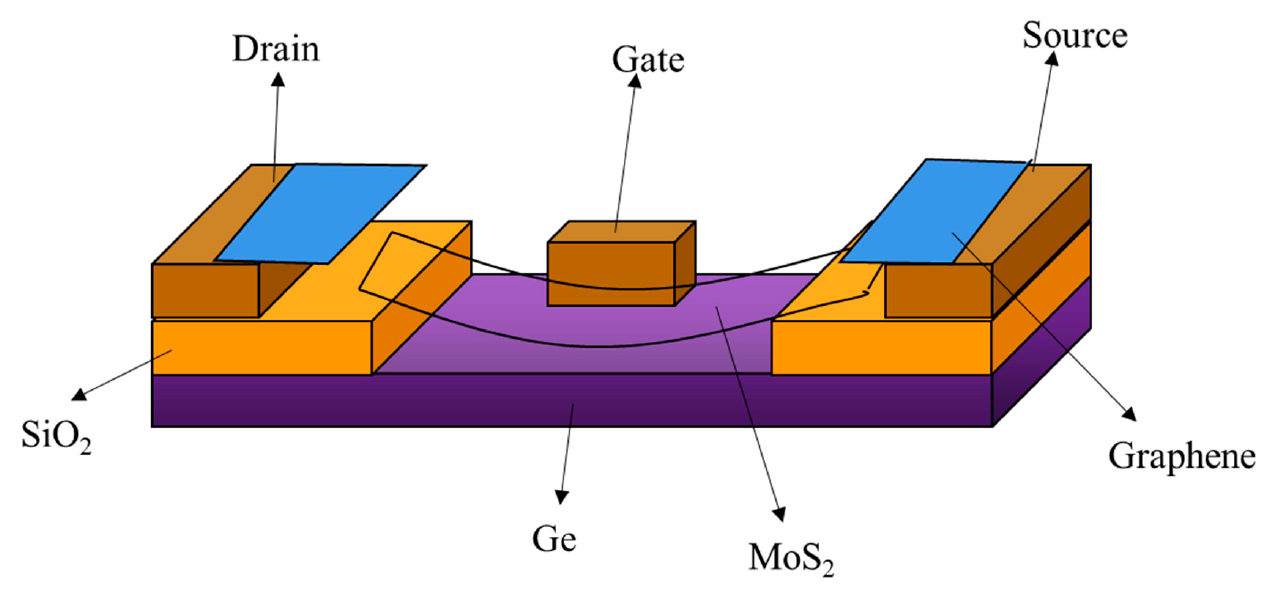
Figure 26. Schematic diagram structure of MoS 2 /Ge heterostructure JFETs